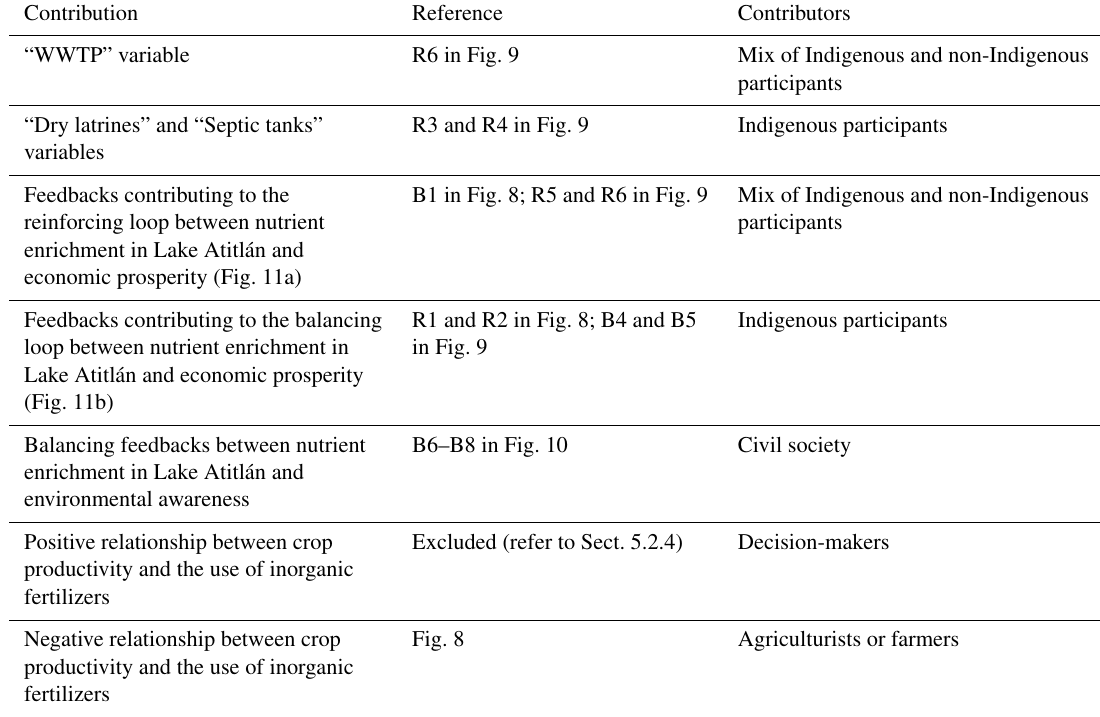
Table 2. Highlights of unique contributions from diverse stakeholder